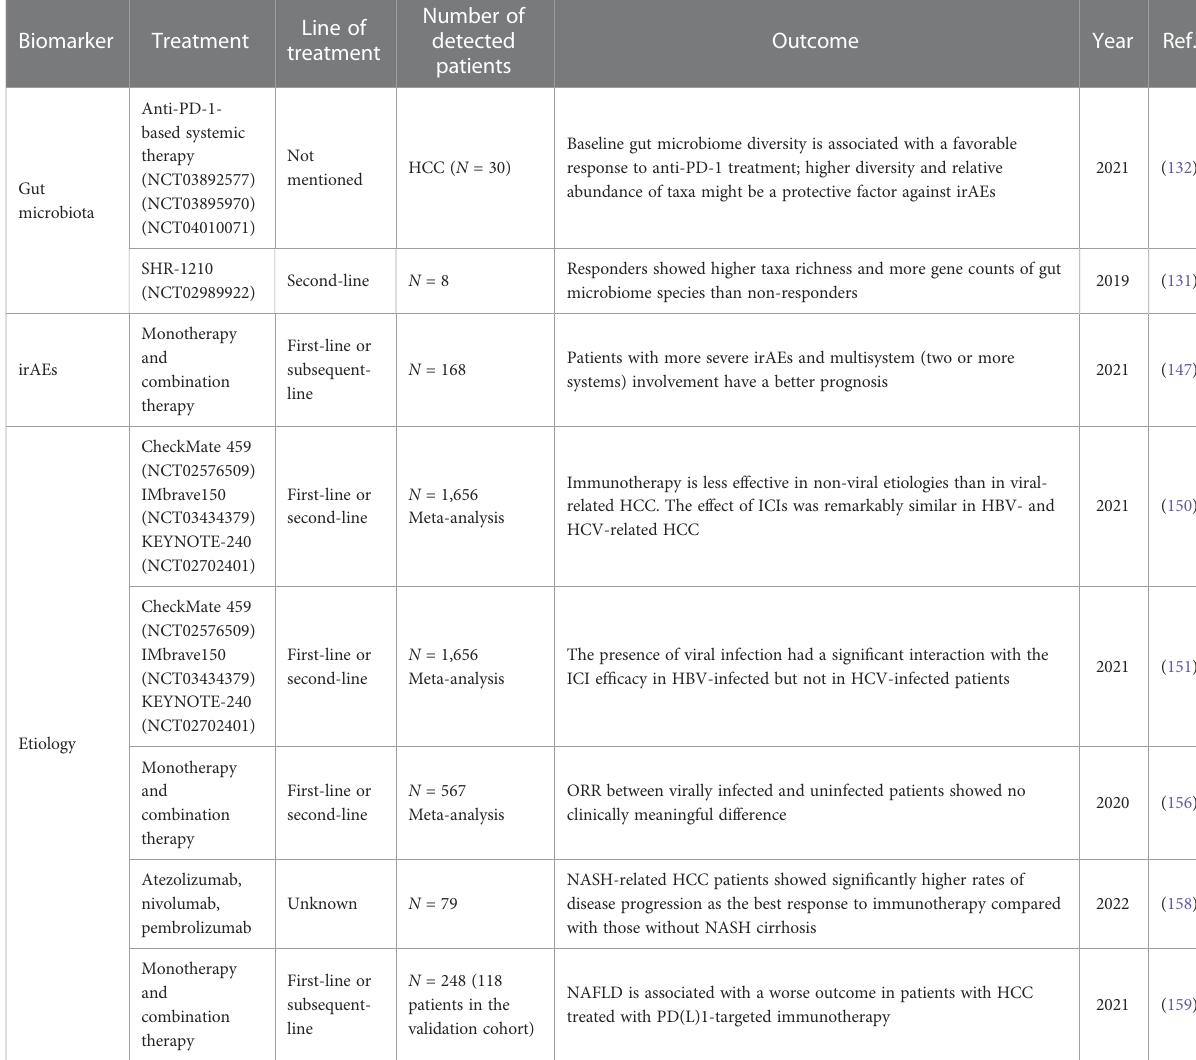
TABLE 3 Predictive or prognostic biomarkers of other types for HCC immunotherapy.